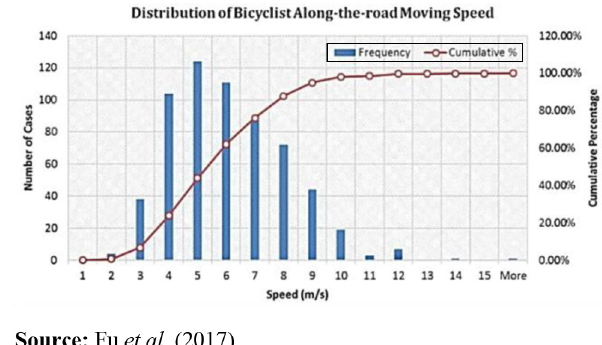
Figure 12 Speed distributions for the bicyclist moving along the road